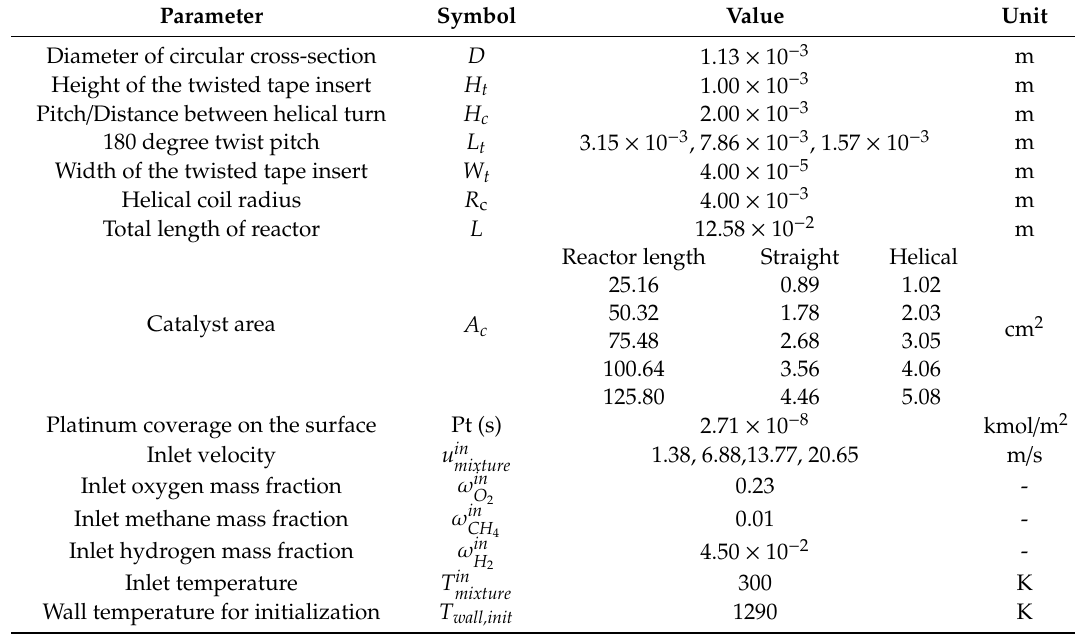
Table 3. Geometric parameters, operating parameters, and material